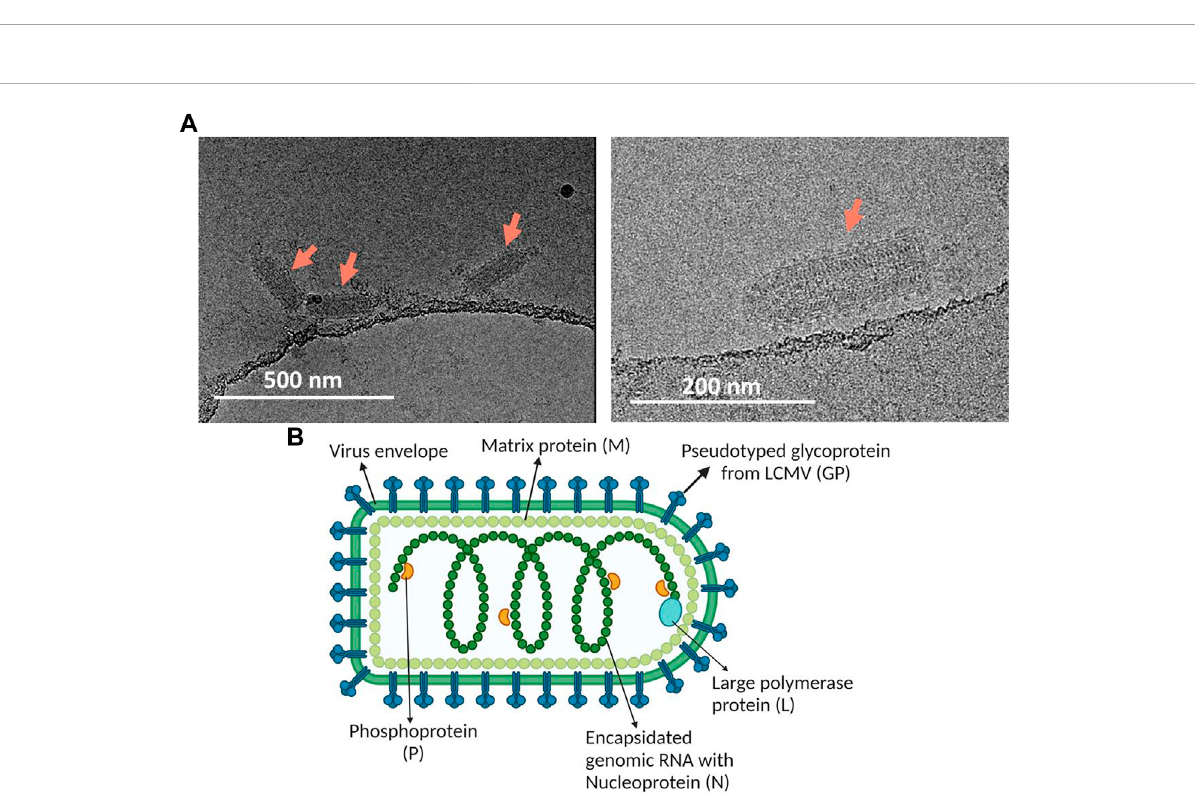
FIGURE 4 (A) Cryo-TEMfor morphologicalcharacterizationofpuri fi edVSV-GPusingSartobind S.Arrowspointtowardsthese